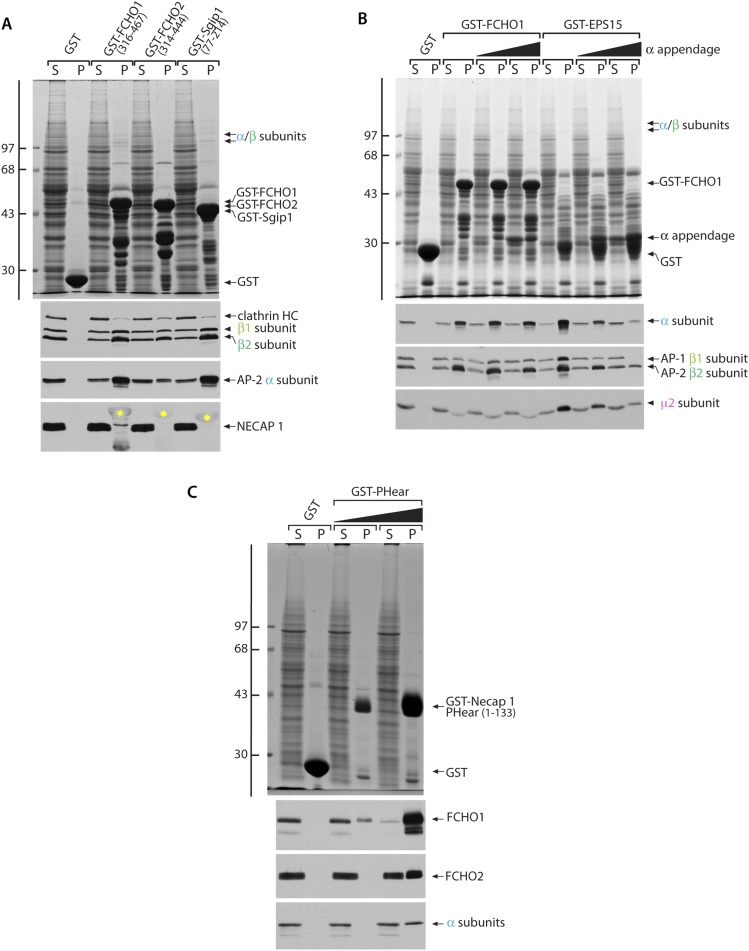
Cytosolic AP-2 and the Necap 1 PHear domain (residues 1–133) bind to FCHO1 and FCHO2.(A) Samples of ∼200 μg of GST, GST-FCHO1 (316–467), GST-FCHO2 (314–740) or GST-Sgip1 (77–214) immobilized on glutathione-Sepharose were used in pull-down assays as in with rat brain cytosol as in Figure 9B. HC; heavy chain. The anti-Necap 1 antibody has extensive non-specific reactivity with the GST-fusion proteins (yellow asterisks) but, compared with the GST control, there is little loss of the Necap 1 from the supernatants after incubation with GST-muniscin linker fusions, as is seen for AP-2 subunits. Thus Necap 1 interacts only weakly with the FCHO1 linker segment. (B) Sample of ∼200 μg of GST, GST-FCHO1 (316–467) or GST-EPS15 (595–740) immobilized on glutathione-Sepharose were used in pull-down assays with rat brain cytosol alone or supplemented with 5 μM or 25 μM purified AP-2 α appendage. The marked recovery of the α appendage together with the GST-EPS15 fusion is not paralleled in the GST-FCHO1 linker pellets, and competition with soluble intact AP-2 is not evident. The reduced apparent abundance of the μ2 subunit in the pellet fractions from the GST-FCHO1 linker pull-down assays is due to comigration of the μ2 subunit with the GST fusion protein. (C) Samples of 250 μg of GST or 50 μg or 250 μg of GST-Necap 1 PHear domain (residues 1–133) immobilized on glutathione-Sepharose were incubated with K562 cell Triton X-100 lysate. After washing, aliquots of the supernatant (S) and pellet (P) fractions were resolved by SDS-PAGE and either stained with Coomassie blue (top) or transferred to nitrocellulose in replicate. Blots were probed with affinity-purified antibodies directed against FCHO1 or FCHO2 or with a mAb (C-8) the α subunit of AP-2. FCHO1, FCHO2 and AP-2 all show dose-dependent interactions with the Necap 1 PHear domain (Ritter et al., 2004, 2007, 2013), although FCHO1 clearly displays the highest apparent affinity. In general, FCHO2 shows a weaker capacity to correct the clathrin distribution phenotype in HeLa clone #64/1.E cells, which is correlated with poorer binding to AP-2 and Necap 1.